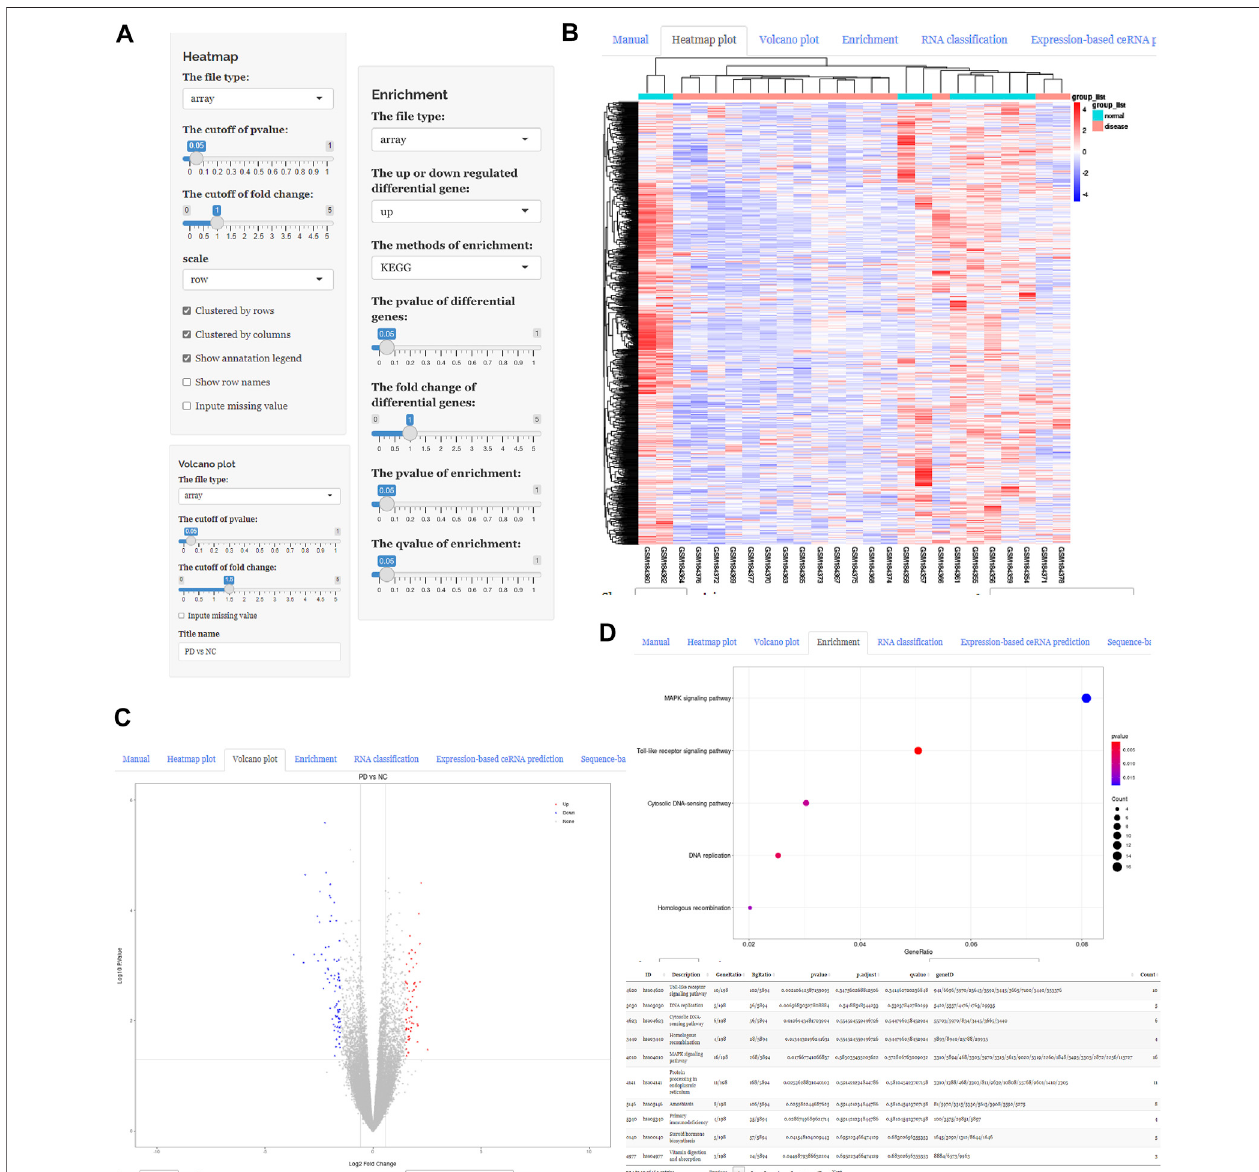
FIGURE 2 | Using ceRNAshiny to generate differentially expressed genes and enrichment analysis. (A) Panels for parameter con fi guration. (B) The generated heatmapplotusingthetemplate dataset. (C) Thegeneratedvolcanoplotusingthetemplate dataset. (D) Thegeneratedenrichment analysisusingthetemplate dataset.